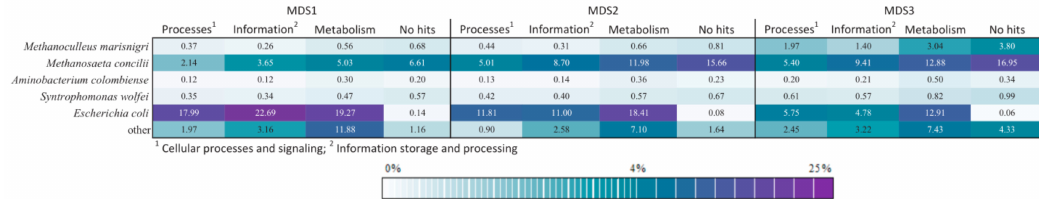
Figure 4. Functional potential combined with taxonomical information using the custom-made pipeline. Counted reads per sample were used to calculate the relative abundance. The functional potential analysis uses the EggNOG database, level 1 classification. The row “other” refers to identified species that are not part of the initial community composition and unassigned reads (for detailed relative abundances see Supplementary File 2: worksheet